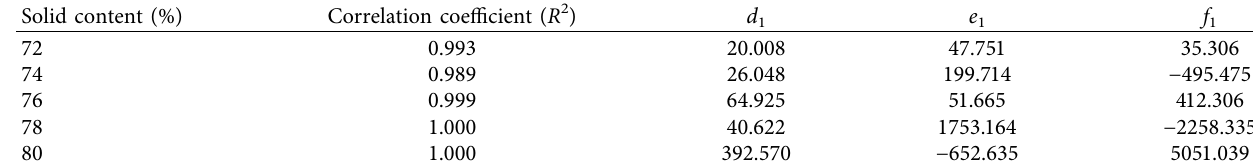
Table 8: Yield stress fitting results of CUTB samples under various c/t ratios.